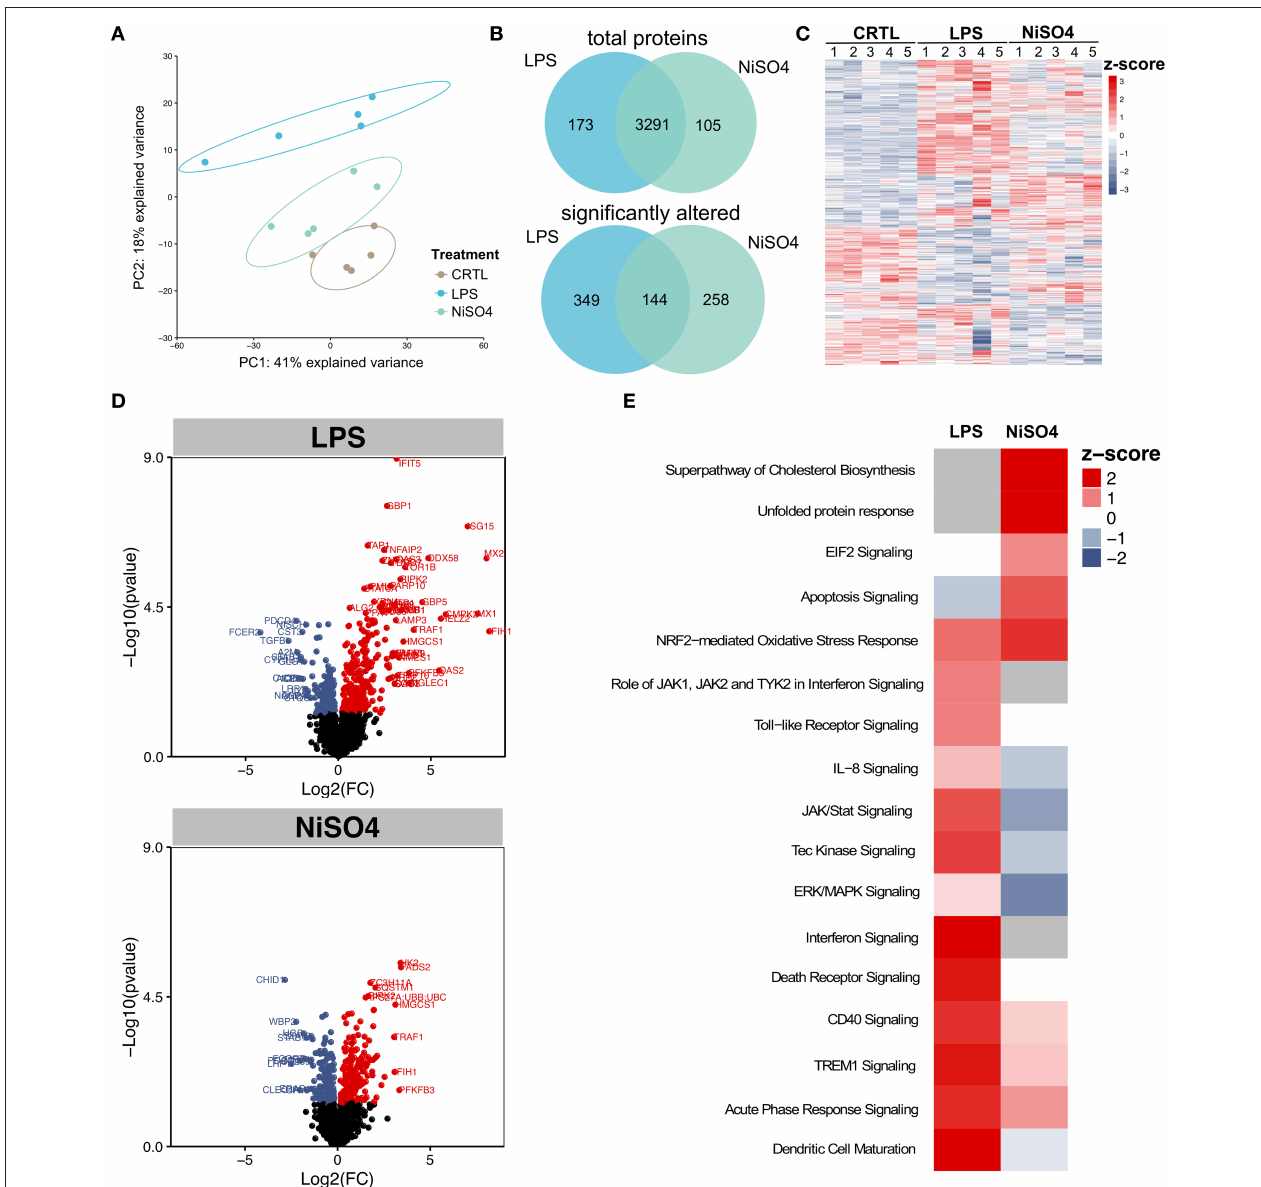
FIGURE 1 | Quantitative proteomic analysis of differentially regulated proteins in LPS- and NiSO 4 -treated MoDCs. (A) Principal component analysis of the five biological replicates showing a distinct clustering of each group, (B) Venn-diagrams of total as well as significantly altered proteins in the LPS-group (blue) and NiSO 4 -group (green), (C) heat map of significantly regulated proteins. Plotted are z-scores for all identified proteins, (D) volcano plots showing significantly regulated proteins for LPS- and NiSO 4 -treated MoDCs compared to untreated MoDCs ( p ≤ 0.05). Mean values of the log2-fold change are displayed and plotted against –log10( p -value), red = upregulation, blue = downregulation, (E) significantly changed pathways in LPS and NiSO 4 -treated MoDCs. Canonical IPA pathways with a positive z-score (red) are predicted to be activated; blue represents a negative z-score and inactivation of the pathway. Gray indicates unmatched pathways. IPA analysis was based on proteins that were significantly changed compared to control ( p ≤ 0.05). Within the IPA software, z-scores were calculated and only experimental data of human origin was allowed. The tissue specificity was set to immune cells. Significance was calculated using Student’s t -test.